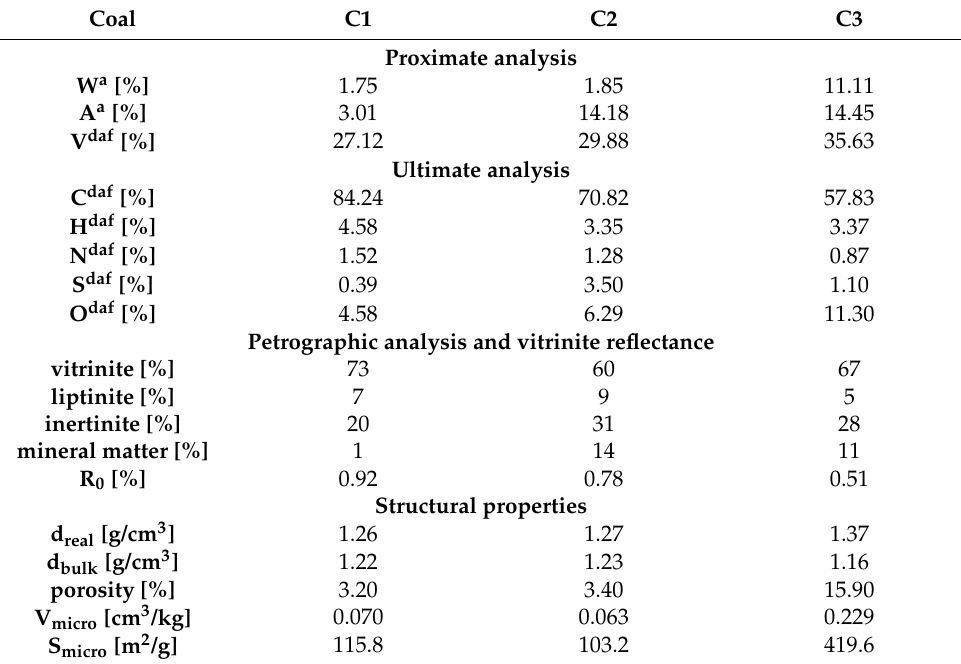
Table 1. Specification of coal samples C1, C2, C3: proximate and ultimate analysis, petrographic analysis, vitrinite reflectance, densities, and